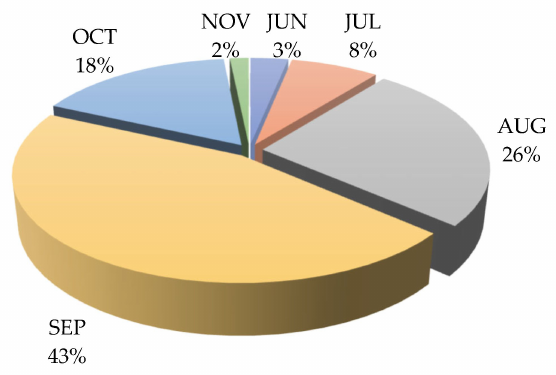
Figure 3. Percentage of Atlantic STCs in each month during the hurricane season of 1950–2020.